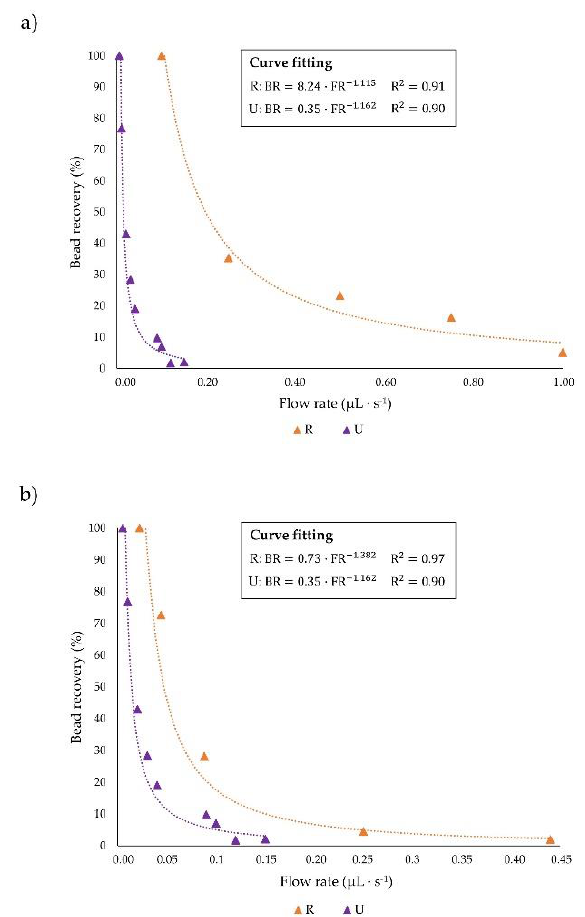
Figure 4. Influence of fluid flow rate on particle recovery when the applied magnetic force is ( a ) different and ( b ) equal in U-shaped and rectangular cross section microdevices.